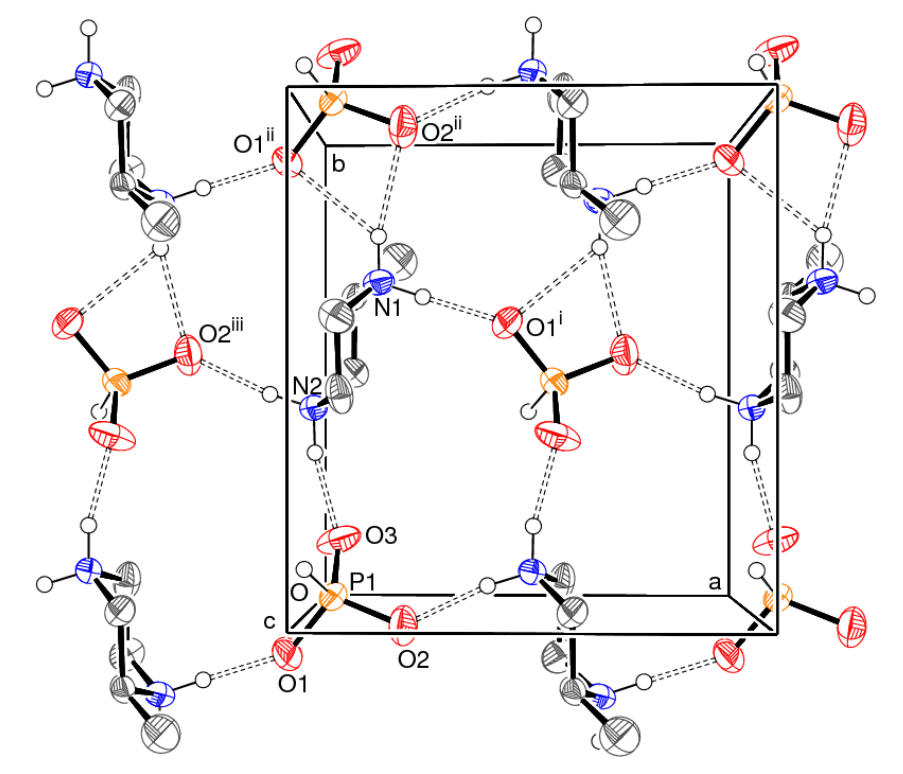
Figure 2. Partial packing diagram for 1 showing part of an (001) cation/anion sheet Hydrogen bonds are shown as double-dashed lines. See Table 1 for symmetry